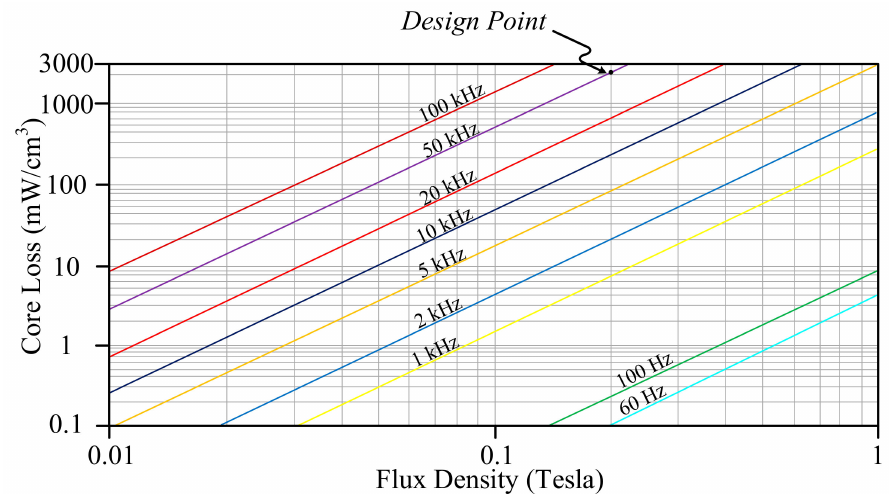
Figure 5. The relationship between core loss and flux density of High Flux, while permeability equals 125 µ